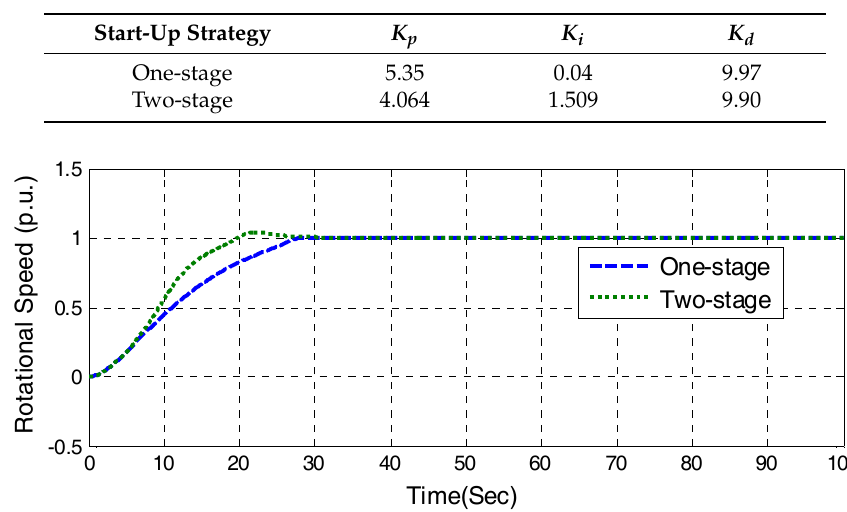
Table 8. Optimized PID parameters in optimization Scheme A.